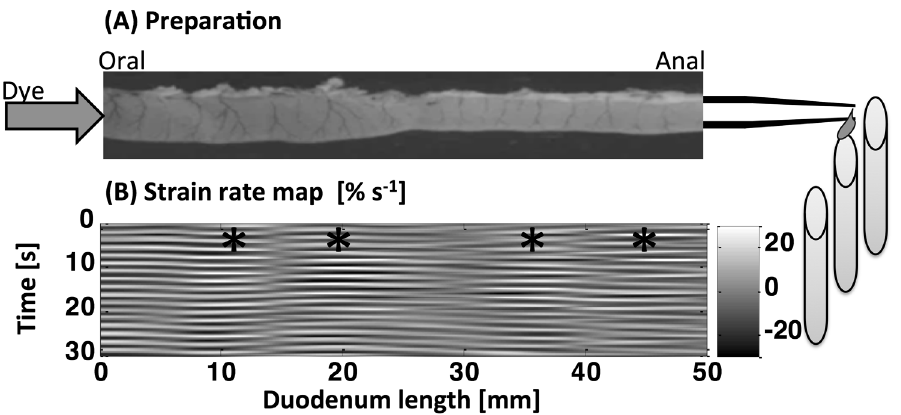
Figure 1. Schema showing the ex vivo preparation and the system for perfusion and collection of the effluent (A) and spatiotemporal L map of non propagating longitudinal contractions, i.e. pendular activity, in the proximal duodenum of the rat (B). (A) The duodenal segment is immersed in, and superperfused with, carboxygenated Earles Hepes solution maintained at 37 u . Effluent is collected every minute from the distal conical cannula tip.(B) Darker shades indicate areas of relaxation (positive longitudinal strain rate, in s 2 1 ) and lighter shades areas of contraction (negative longitudinal strain rate). The L map presents four spatial domains (*) in which the longitudinal strain rate oscillates between positive and negative values.